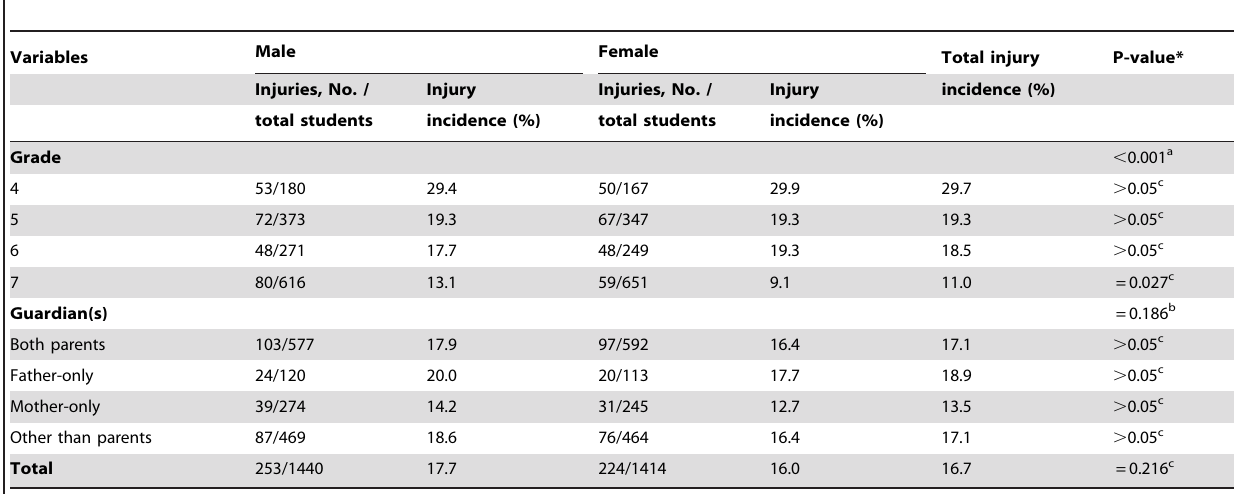
*Different letters indicate significant difference by grade a , guardian situation b , gender c . doi:10.1371/journal.pone.0102099.t001 PLOS ONE |